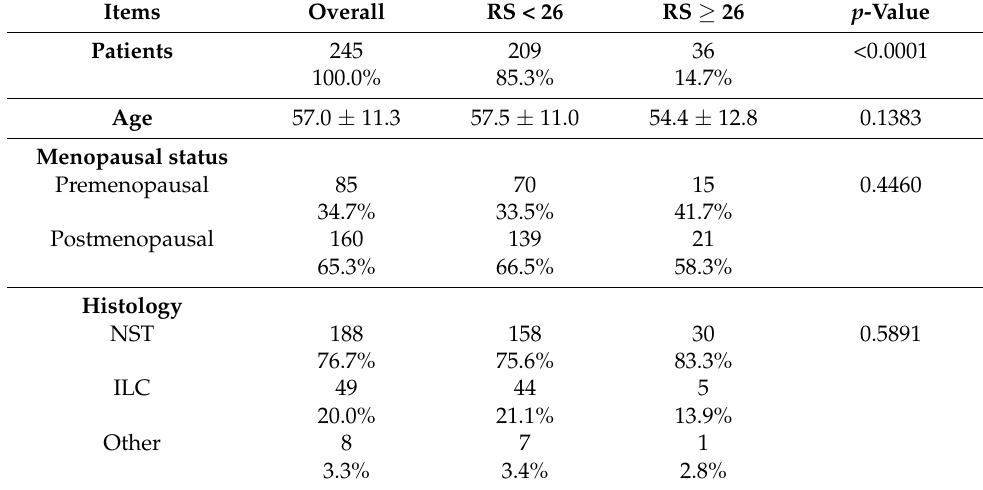
Table 1. Overall patient